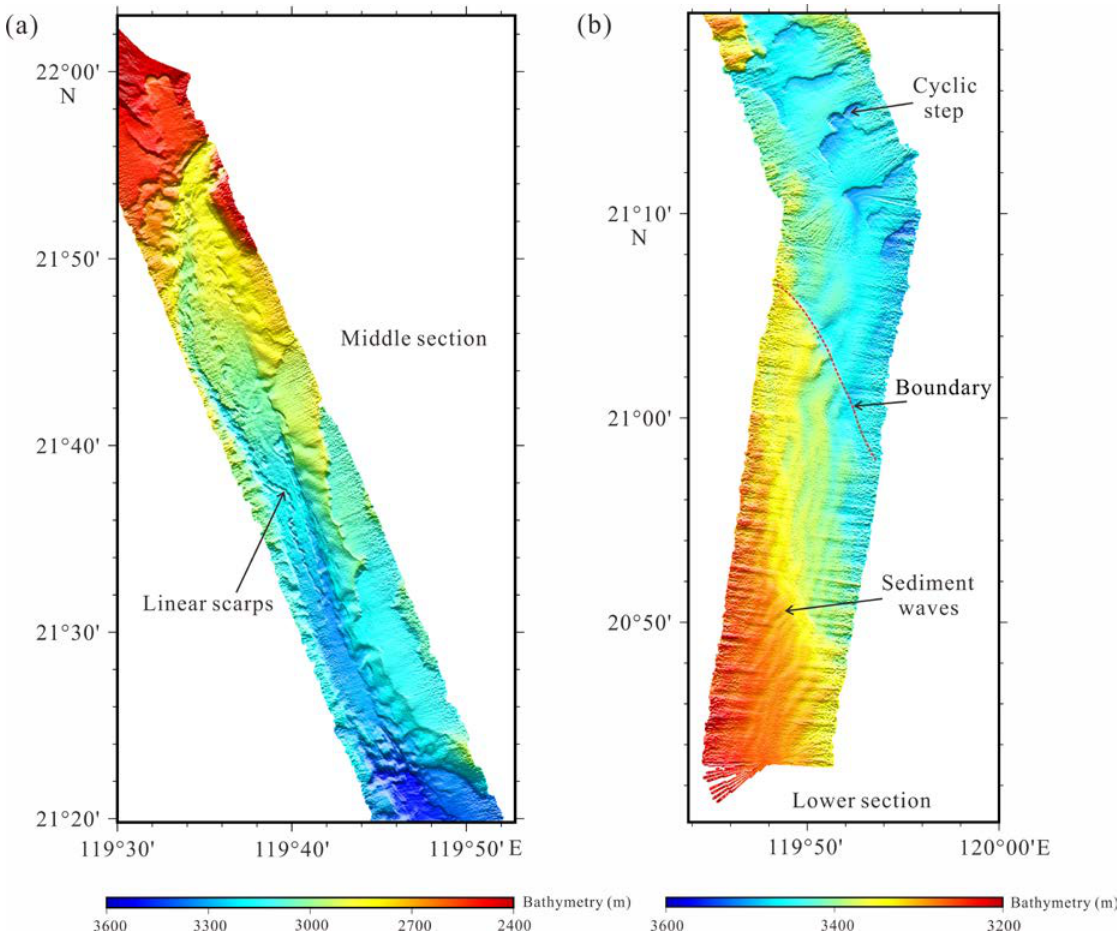
Figure 3. Multibeam bathymetric map of the Penghu canyon. ( a ) Topographic map of the middle section of the Penghu canyon with a linear scarp; ( b ) topographic map of the lower section of the Penghu canyon. Six cyclic steps and sediment waves are identified in the lower section of the Penghu canyon.